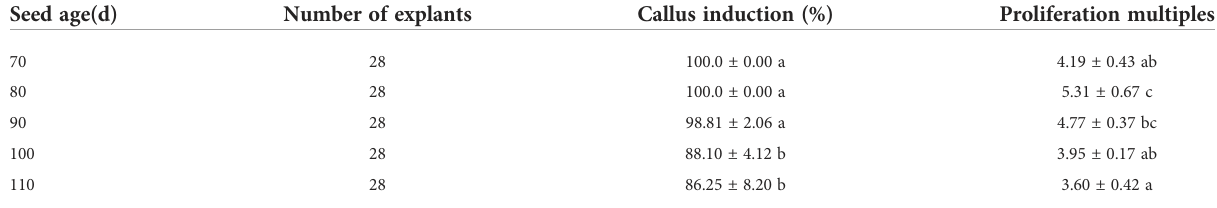
TABLE 3 Effects of different developmental stages on callus induction.